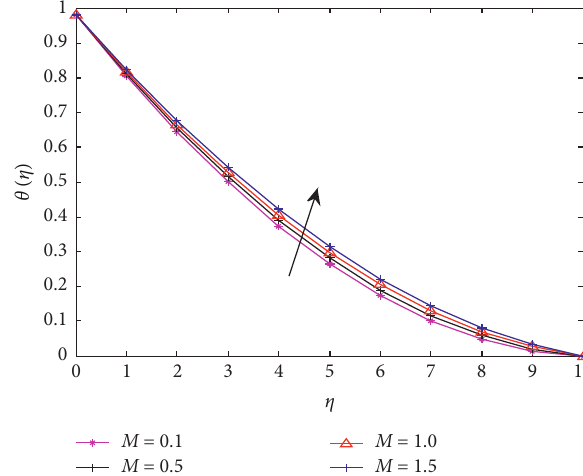
Figure 15: Temperature sketch for altered values of M when